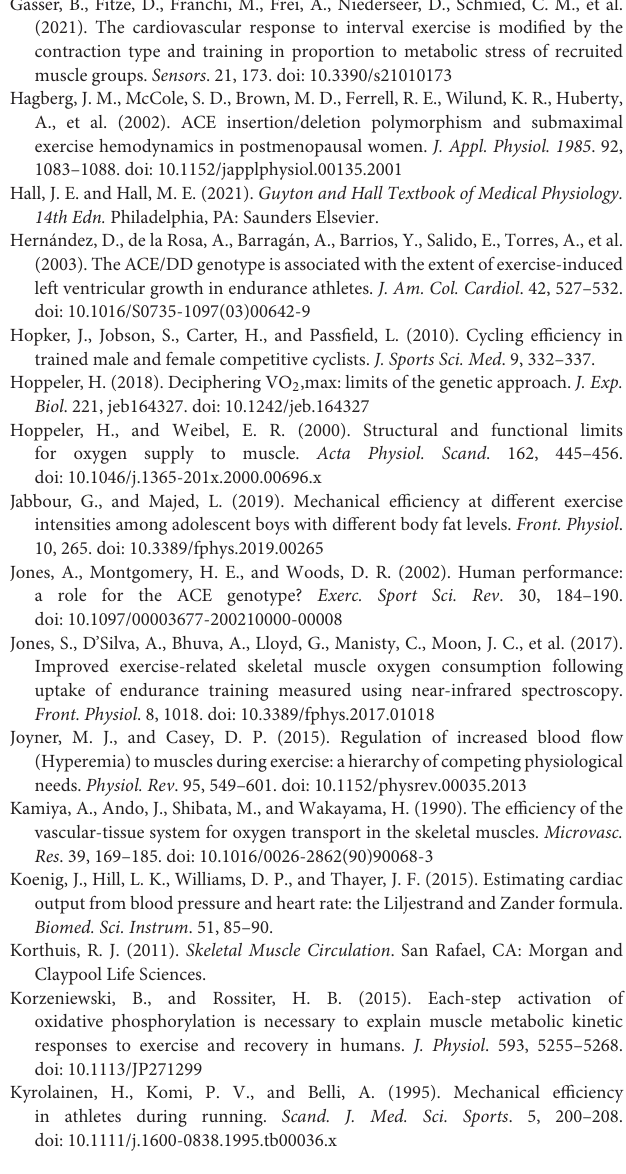
corresponds to the highest and lowest connectivity. Note the high interactivity of linear relationships with PO. Supplementary Figure 2 | Control analysis — Line graphs visualizing the linear relationships between fractional changes per time for parameters of the pathway of oxygen and fractional changes in PO over the different metabolic phases of the ramp exercise test. Circles and vertical lines indicate the median + SE for the different parameters in the metabolic phases (rest, work, recovery, and transitions in between). Only values of parameters were shown which were resolved at the selected scale. Red and blue zones indicate exercise (red) and recovery (blue) phases of the exercise test. n = 44. Supplementary Table 1 | Sensitivity analysis on the influence of threshold of fitness on statistical sizes. Values refer to p-values, effect sizes and statistical power for main effect of the factors genotype (D-allele, no D-allele) × fitness (fit, unfit) on power-related slopes for the given parameters. Multifactorial ANOVA. Fitness was calculated with different method based on reference values. Thld50: